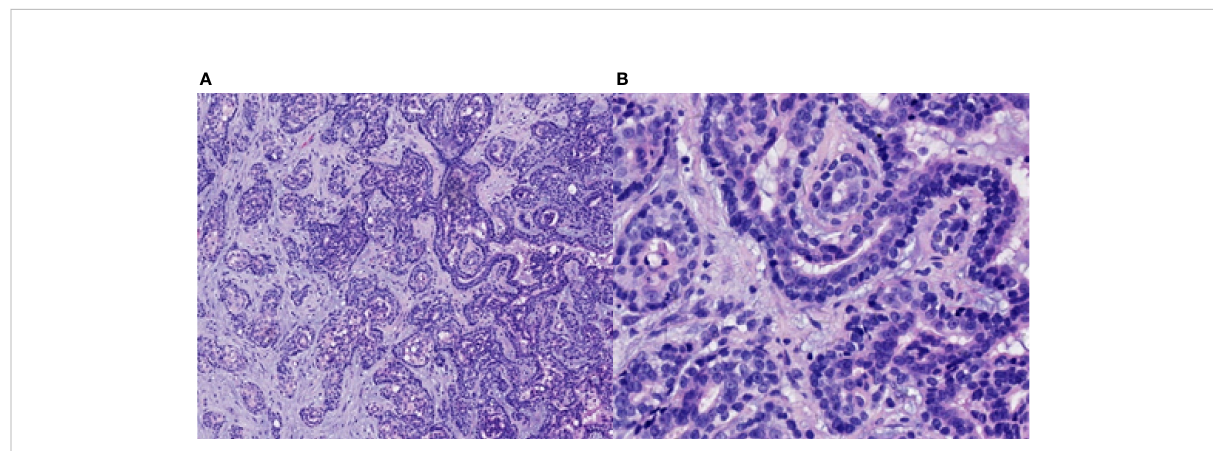
FIGURE 2 Pathological fi ndings of the nasopharyngeal biopsy obtained on 17 April 2019. The EMCa of the nasopharynx was mainly composed of an inner layer of epithelial cells and an outer layer of clear cytoplasmic myoepithelial cells. H&E staining; magni fi cation, ×10 (A) and ×40 (B) . EMCa, epithelial – myoepithelial carcinoma; H&E, hematoxylin and eosin.